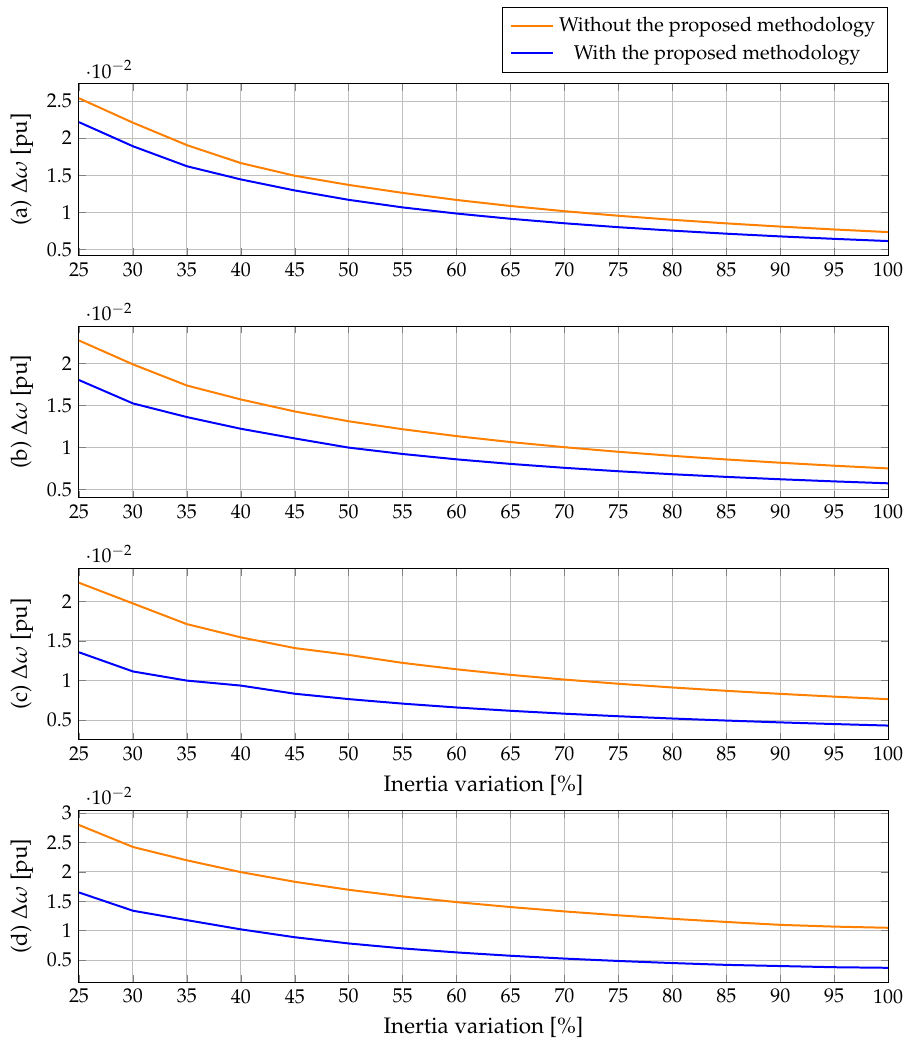
Figure 11. Maximum average of ∆ ω when the inertia of the synchronous machines is reduced: ( a ) 10%, ( b ) 30%, ( c ) 50%, and ( d ) 80%